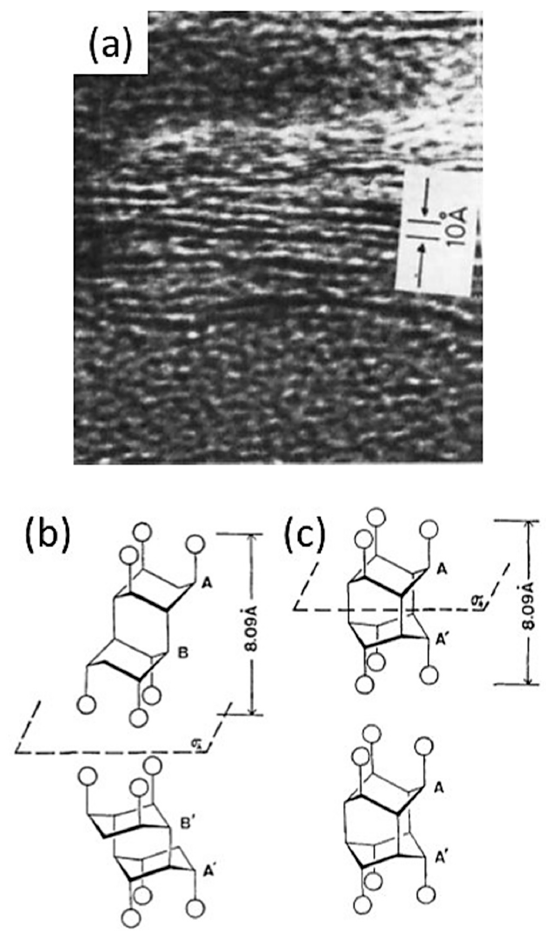
Figure 4. Scanning electron micrograph of (C 2 F) n ( a ) and structural models for stacking patterns of carbon difluoride in adjacent layers AB/B (cid:48) A (cid:48) ( b ) and AA (cid:48) /AA (cid:48) ( c ) ( σ h is a mirror plane perpendicular carbon difluoride in adjacent layers AB/B ′ A ′ ( b ) and AA ′ /AA ′ ( c ) ( σ h is a mirror plane perpendicu- to the principal symmetry axis) lar to the principal symmetry axis) [28].